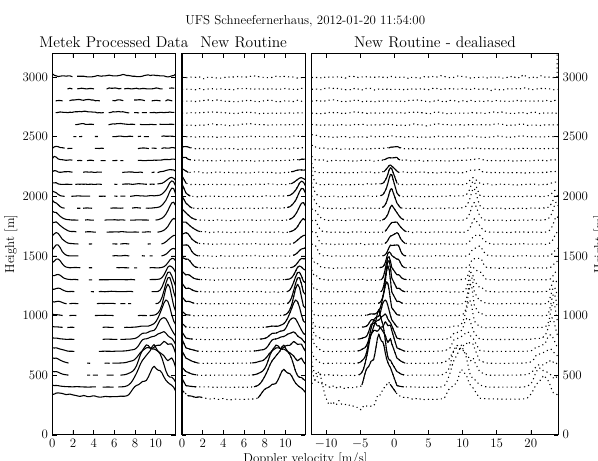
algorithm sorts a single Doppler spectrum by amplitude and